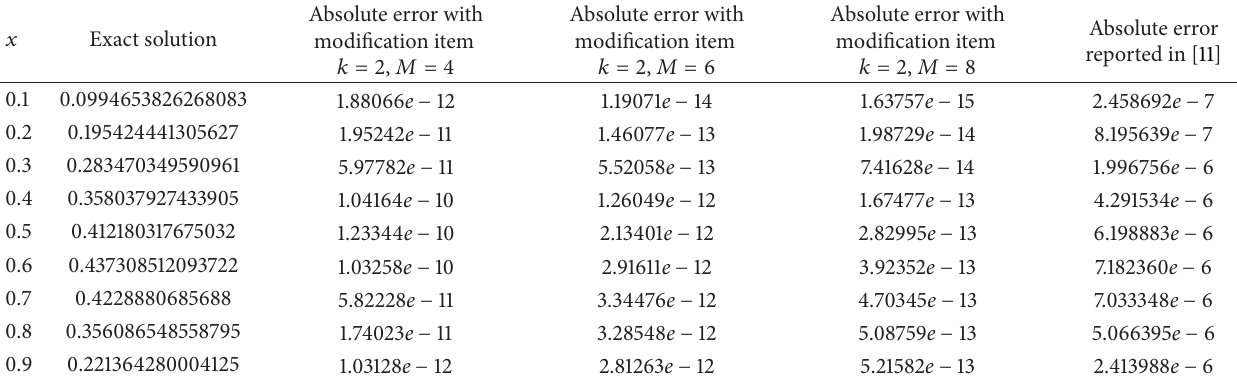
Table 2: Comparison of numerical results for Example 1.